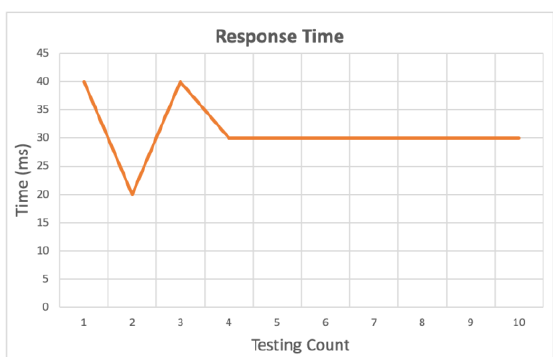
Figure 11. Response time of publish/subscribe between different devices. Pi 3 publishes a message as a